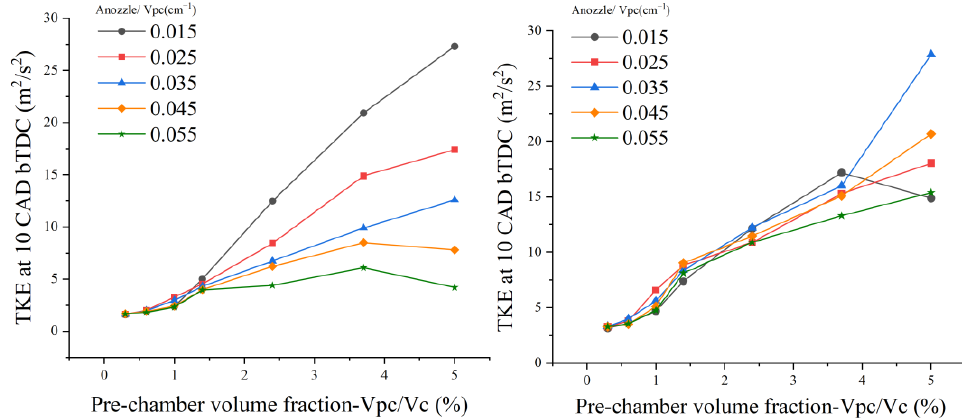
Figure 11. TKE at 10 CAD before and after TDC.